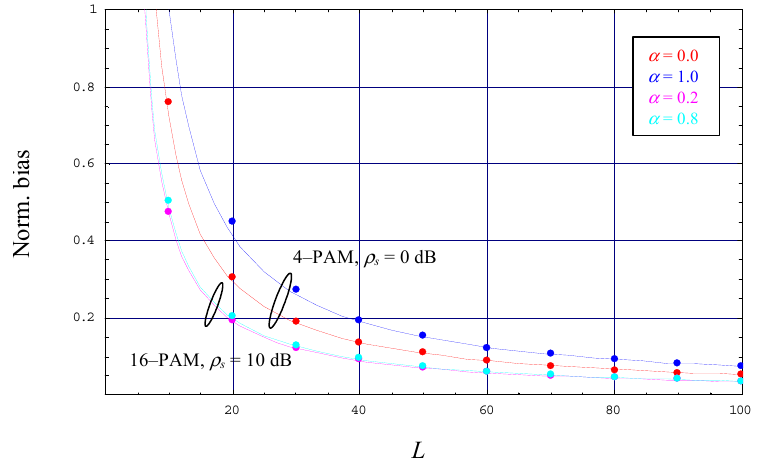
Figure 2. Evolution of the normalized bias. The evolution of the normalized bias has been simulated and verified for modulation schemes other than 4-PAM and 16-PAM, e.g., 2-PAM and 8-PAM, as well as for roll-off factors different to those exemplified in Figure 2. It turned out that the bias of the estimator algorithm is reflected accurately enough by the formula in (43), disappearing for very large values of L irrespective of the selected values of M or α